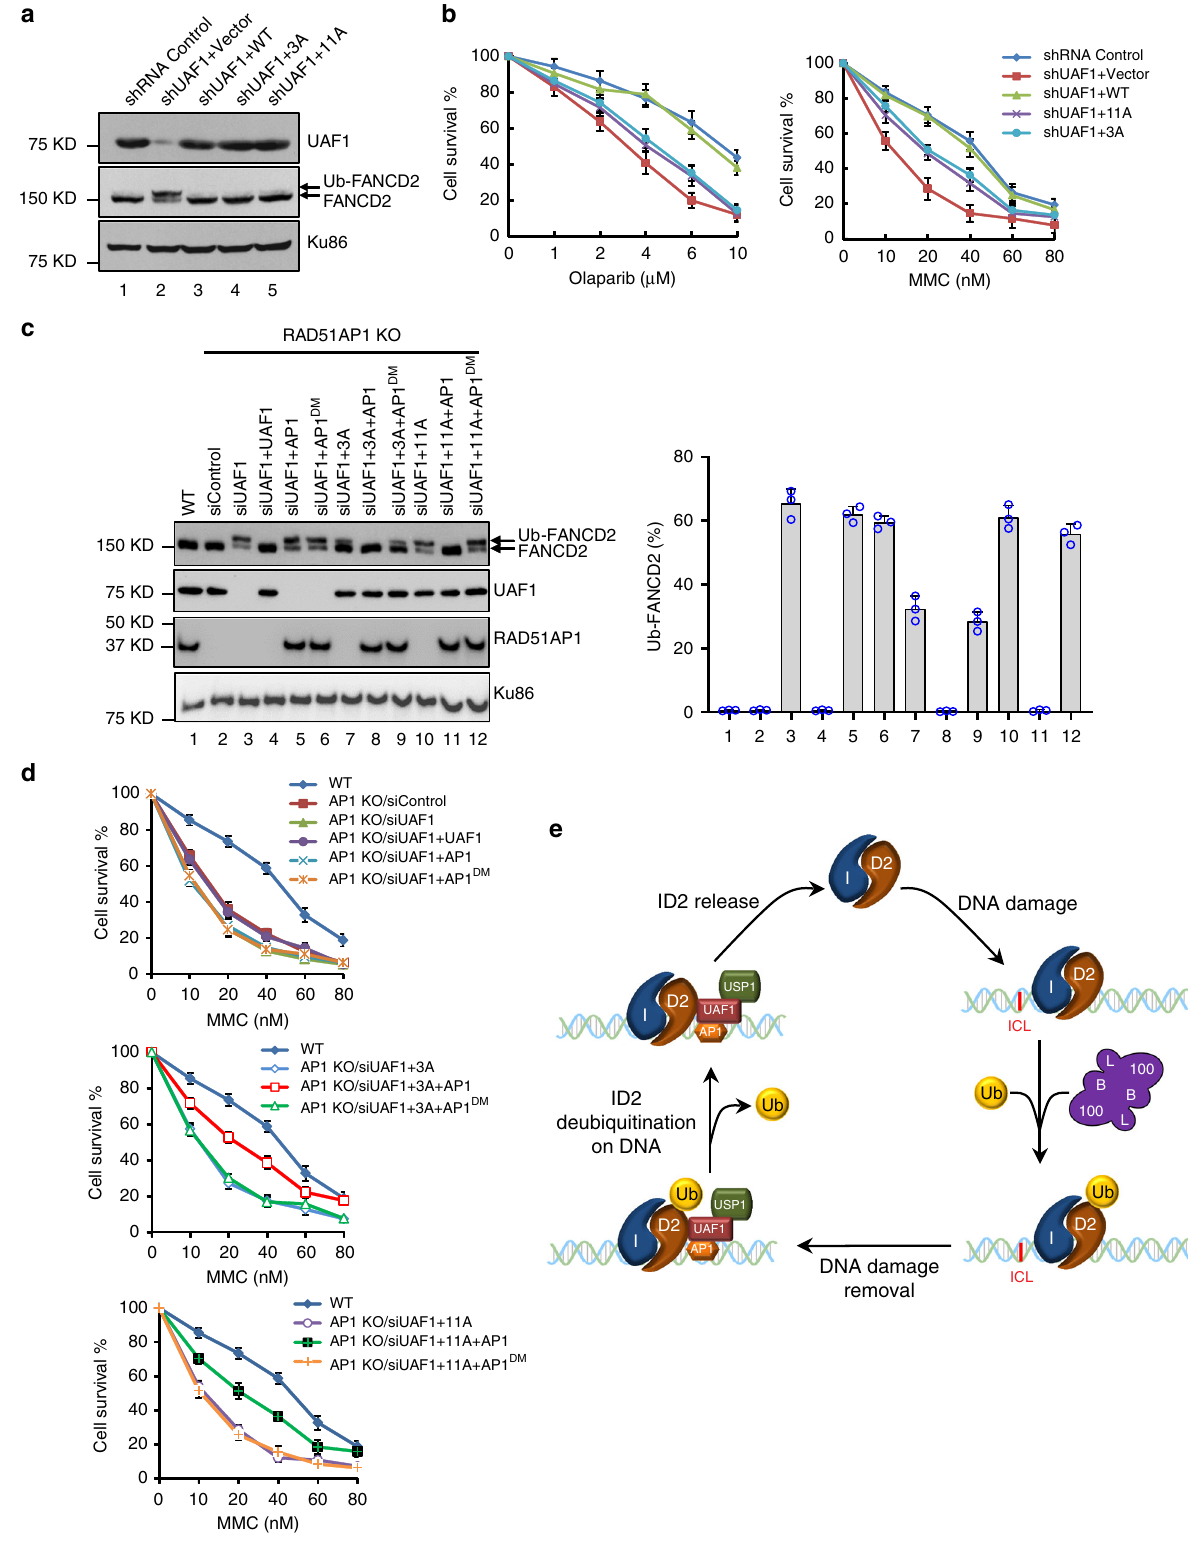
(Invitrogen) at a density of 1 ×10 6 cells/ml. After a 48-hour incubation at 27°C, Supplemental Table 3) was synthesized by Genewiz. Bacmids were generated in E. coli strain DH10Bac. cells were collected by centrifugation and stored at − 80°C. All puri fi cation steps were performed at 0 – 4°C. A 6-g cell pellet (from 400 ml of insect cell culture) was thawed in 50ml cell breaking buffer (20 mM Tris-HCl, pH 7.5, 10% glycerol, Puri fi cation of UAF1 and mutants . The Bac-to-Bac TOPO expression system (Thermo Fisher) was used to generate recombinant baculoviruses in Spodoptera frugiperda (Sf9) cells (Invitrogen). Viruses were used to infect HighFive insect cells NATURE COMMUNICATIONS| (2019) 10:2849